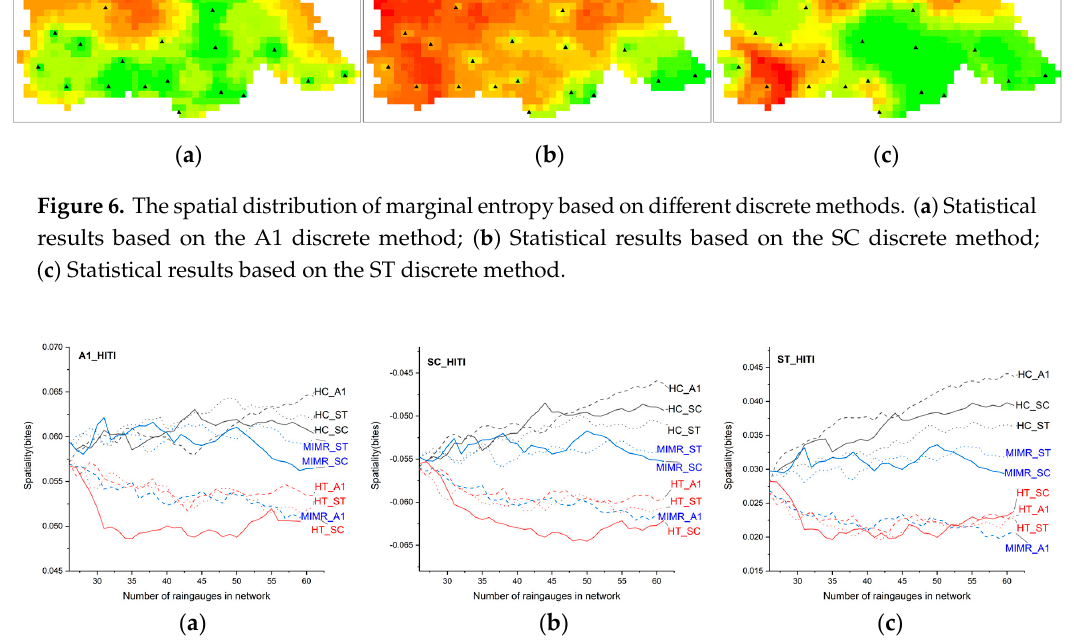
Figure 7. Comparison of network spatiality. ( a ) Spatial statistics of the A1 discrete method based on remote sensing data; ( b ) Spatial statistics of the SC discrete method based on remote sensing data; ( c ) Spatial statistics of the ST discrete method based on remote sensing data.